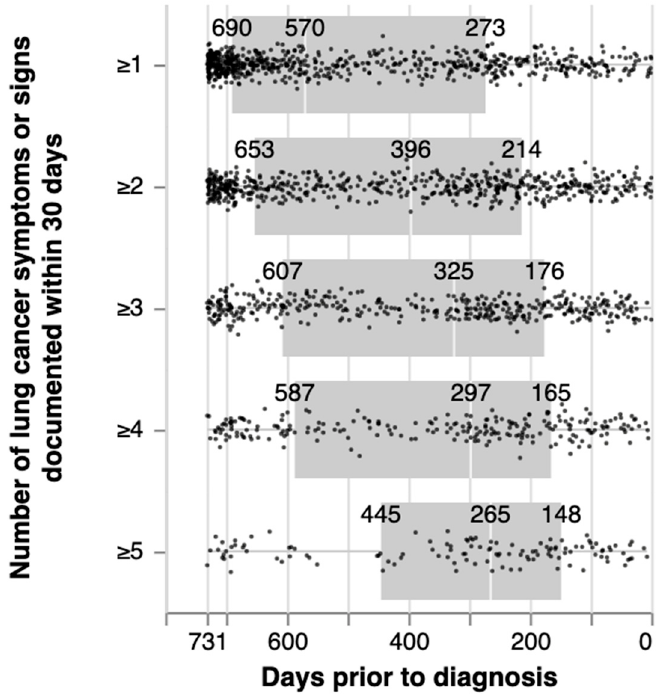
Figure 2. Length of time between first recorded symptom/sign potentially associated with lung cancer within two years (24 months) of diagnosis and date of diagnosis. Note: 30-day window means x-number of symptoms recorded in the EHR within 30 days of one another, not necessarily the same visit.